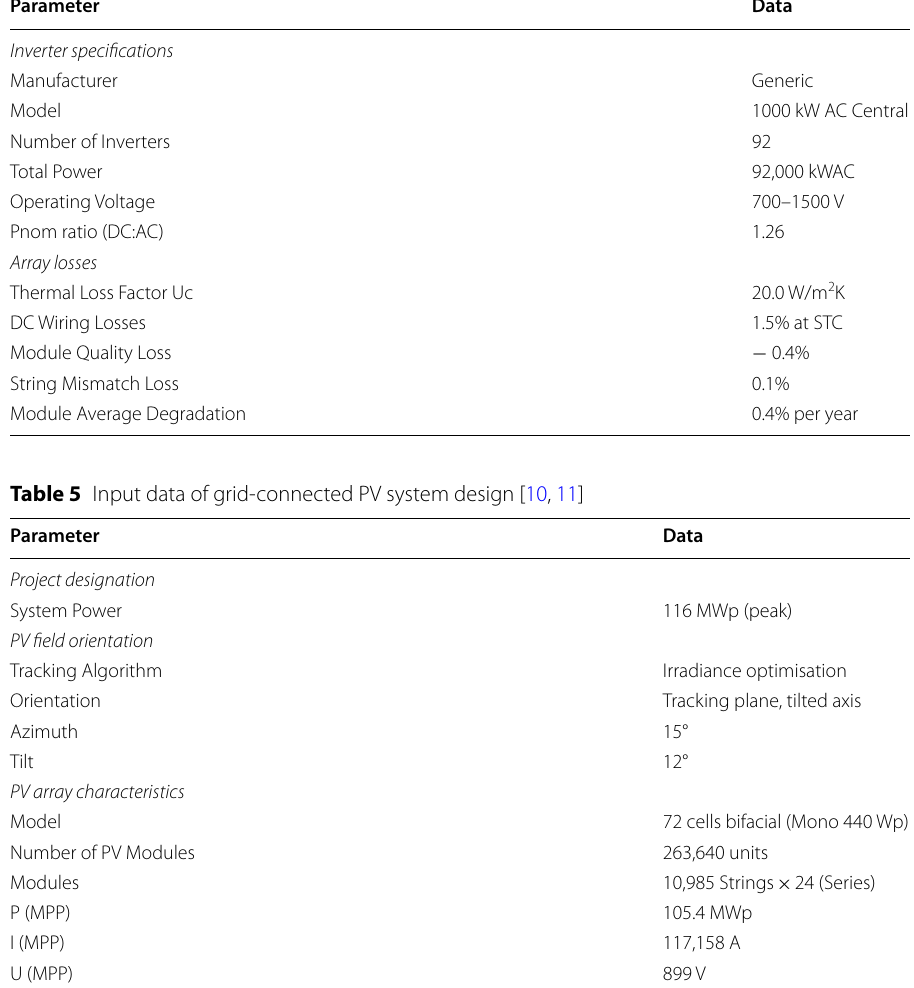
Table 4 Inverter design results of the grid-connected PV system Parameter Data